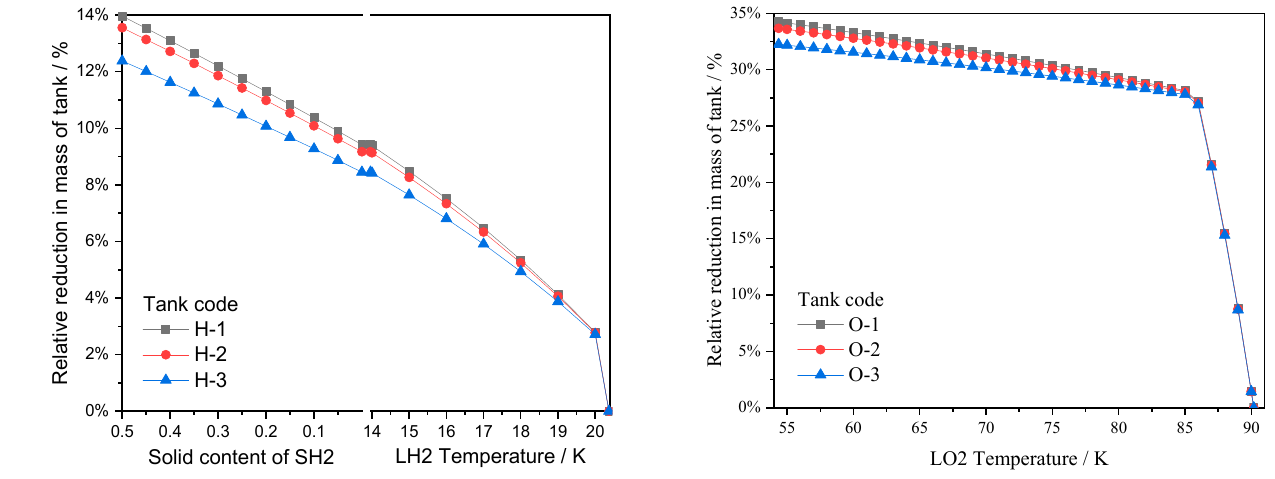
Figure 9. Relationship between LH2/LO2 densification degree and tank mass.